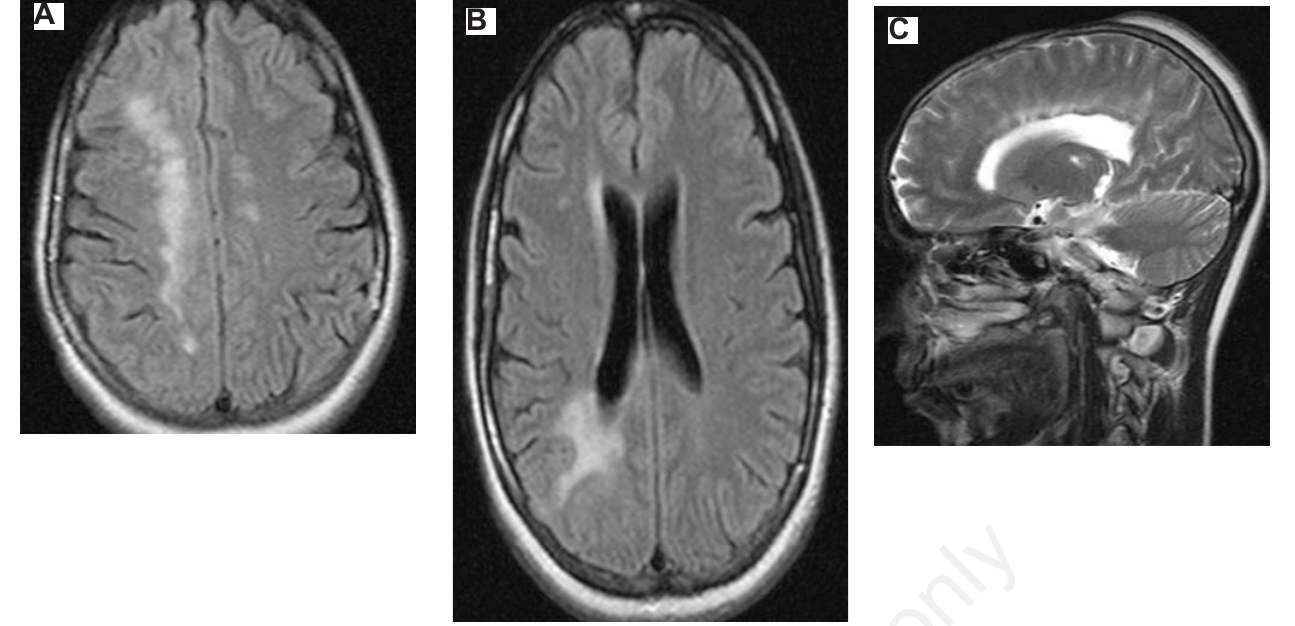
Figure 3. A) Axial T1 FLAIR magnetic resonance imaging (MRI) showing bilateral periventricular hyperintensities at supra ventricular level with temporal and parietal lobe cortical atrophy more prominent in the right cerebral hemisphere; B) axial T1 FLAIR MRI showing periventricular hyper intensities, consistent with a leukoariaosis type pattern and right frontal, temporal and parietal lobe cortical atro- phy; C) sagittal T2 MRI showed involvement of the corpus callosum with T2